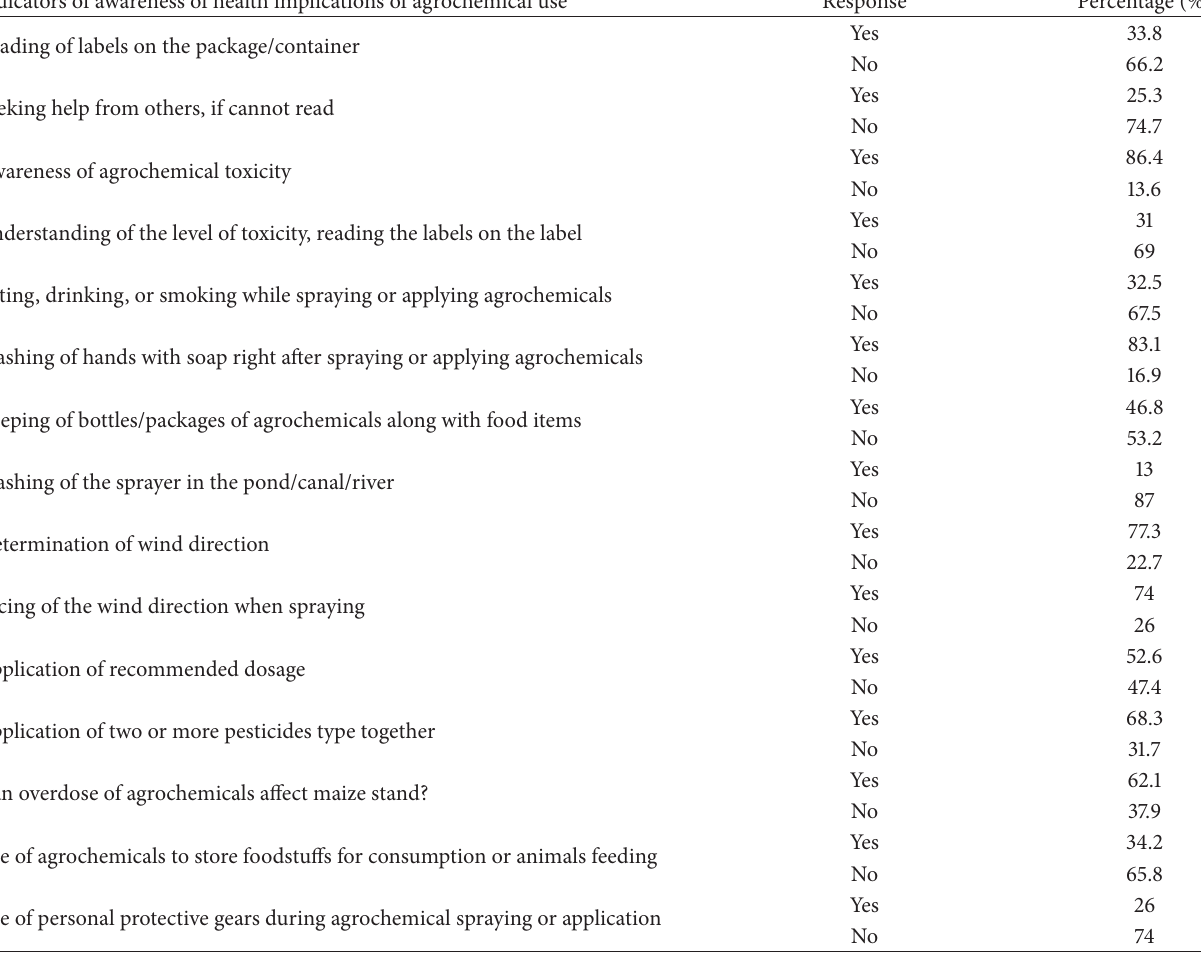
Table 4: Farmers response to indicators of awareness of health implications of agrochemical